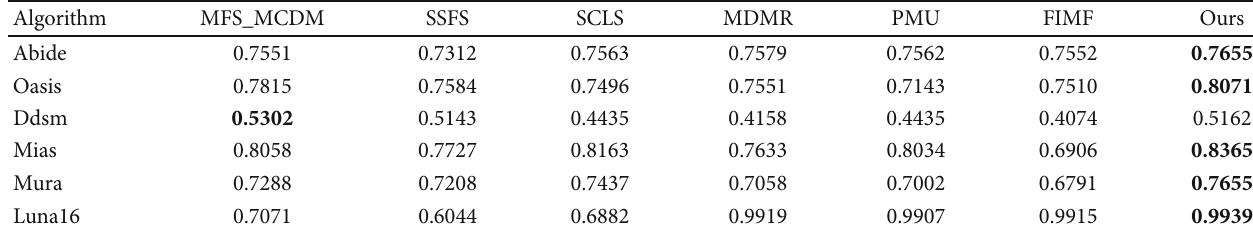
Table 7: Display of optimal experimental results under index average